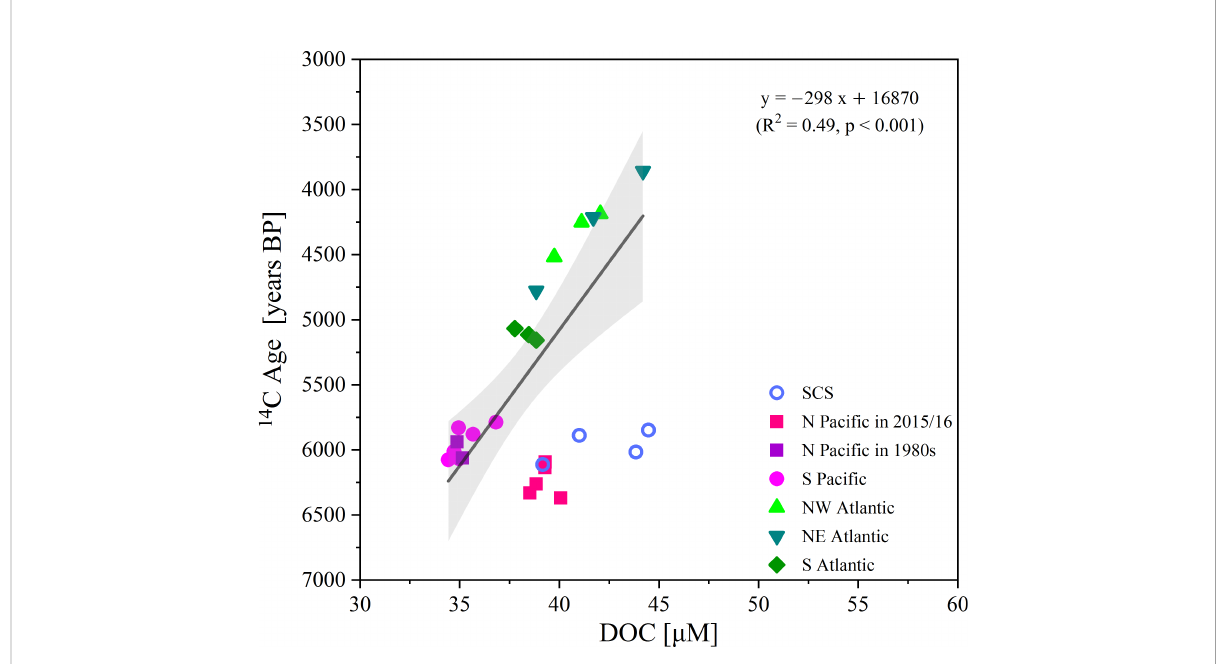
FIGURE 9 Average 14 C-DOC ages versus average DOC concentrations at four stations in the northern SCS and in other open ocean sites in the Paci fi c and Atlantic. Data derived from the SCS (Ding et al., 2020), NP (Druffel et al., 1992; Druffel et al., 2019; Druffel et al., 2021), South Paci fi c (Druffel and Grif fi n, 2015; Druffel et al., 2021), and Atlantic (Druffel et al., 2016). The solid line is the Model II geometric mean regression of all points excluding the SCS, and the gray area marks the 95% con fi dence interval of the linear regression. The equation is also shown in the fi gure, with a slope of -298 ± 48 and a y-intercept of 16,870 ±